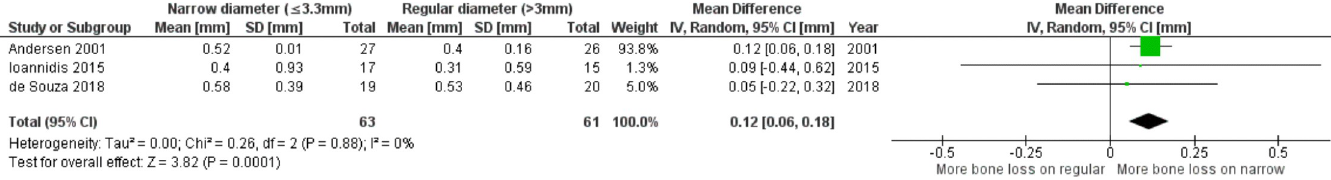
Fig 4. Forest plot of all intervention studies comparing marginal bone loss between narrow and standard